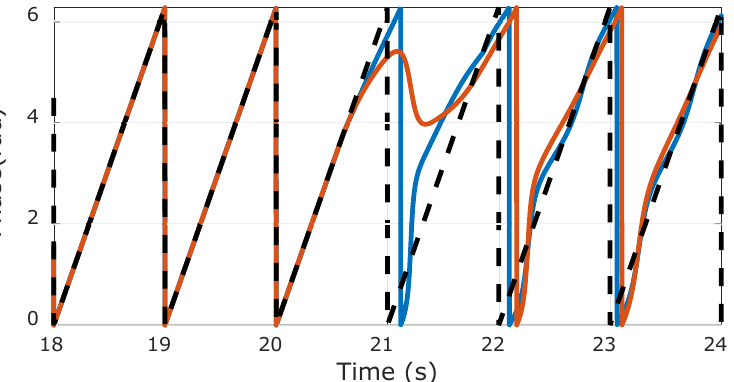
Figure 5. Phase estimation results. The black line is the reference phase, the blue line is the estimated phase of the proposed method, and the red line is the estimated phase of the AO.